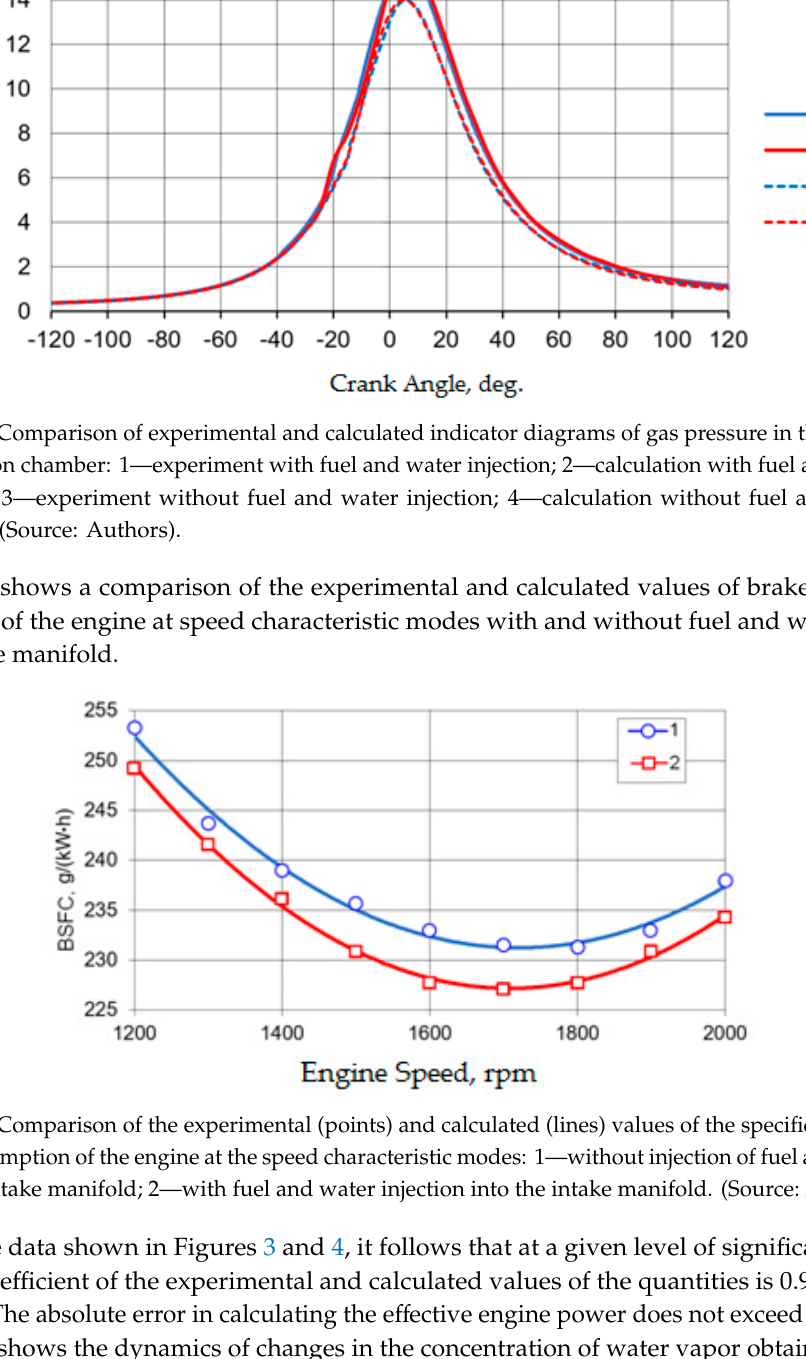
Figure 4. Comparison of the experimental (points) and calculated (lines) values of the specific effective fuel consumption of the engine at the speed characteristic modes: 1—without injection of fuel and water into the intake manifold; 2—with fuel and water injection into the intake manifold. (Source: Authors).